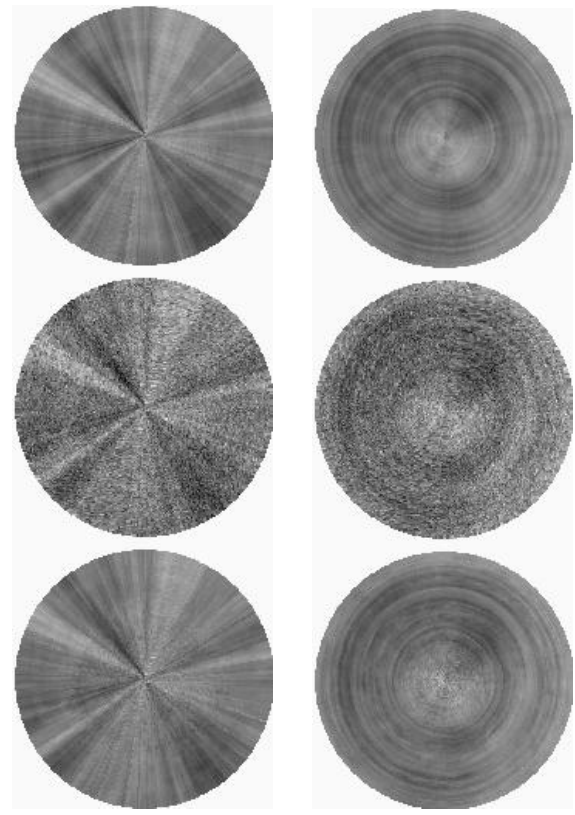
Figure 13. Filtration of circular images: (top) informative images, (middle) noisy images, (bottom) filtered